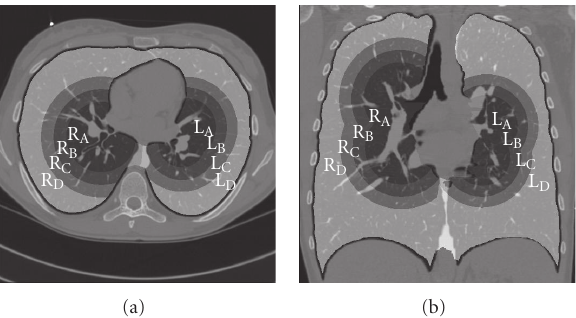
Figure 6: Eight distinct regions were delineated based upon their radial distance from the hilum. Two points were manually placed in each lung as landmarks denoting the hilum and the lung was three- dimensionally divided into a total of eight regions depending on the distance from the hilar points. Note that this interaction step is only used for the validation